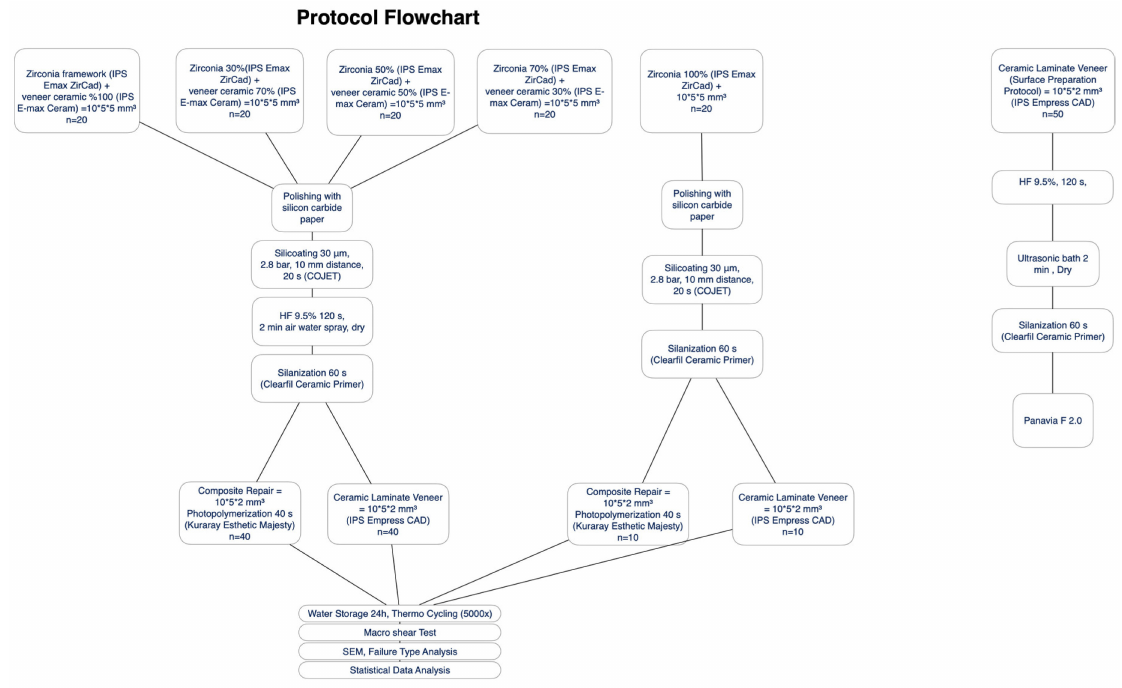
Figure 1. Experimental flowchart presenting the distribution of the tested groups according to testing method, substrate, and procedural sequences of the experiment. Table 1. Product names, manufacturers, and the respective chemical compositions of the study